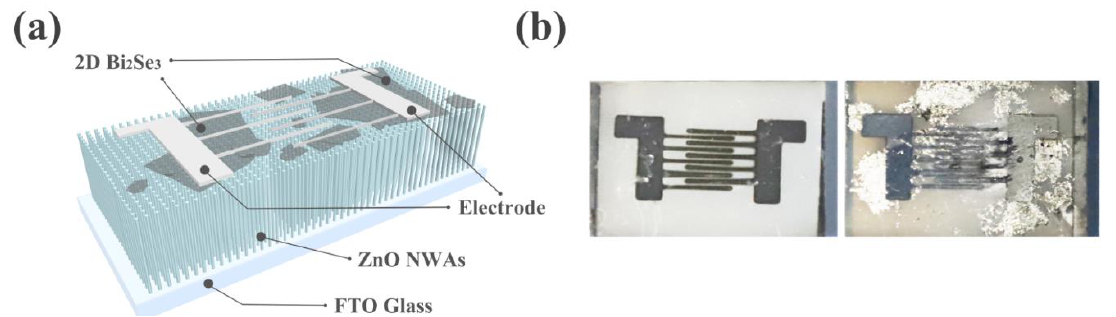
Figure 1. ( a ) the structure diagram and ( b ) physical image of photodetector.